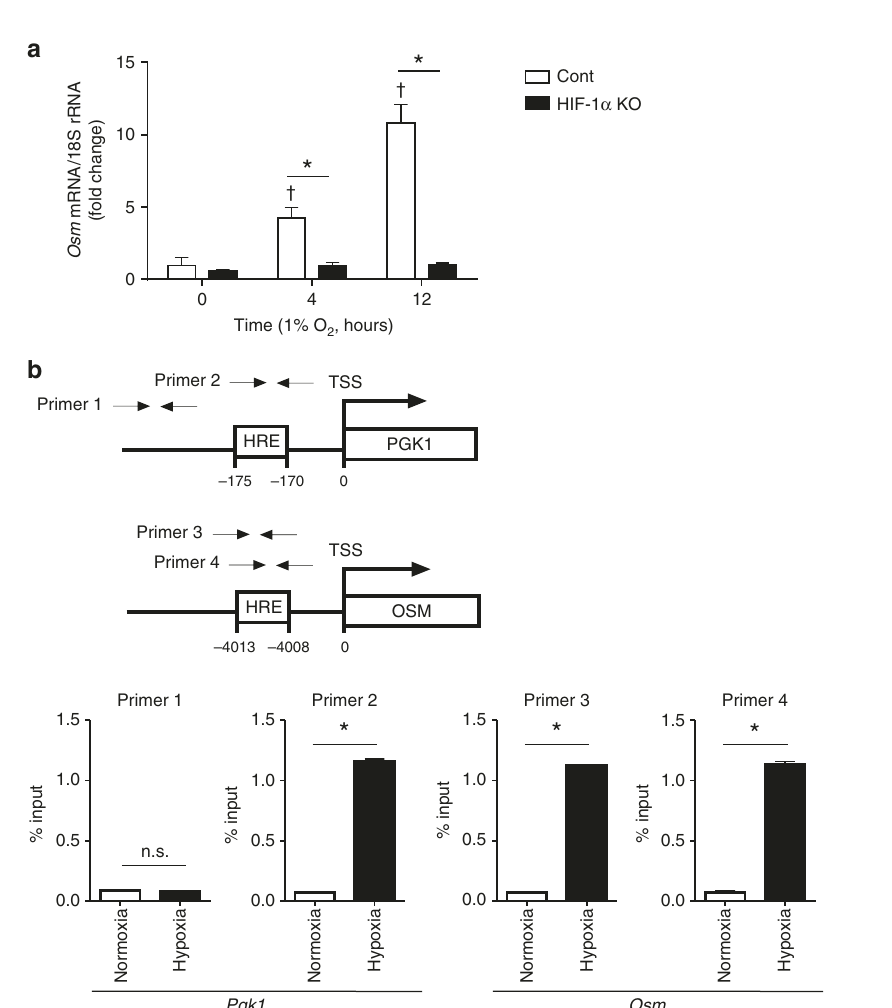
Fig. 3 Oncostatin M from hypoxic M Φ inhibits fi broblast activation. a Supernatants were collected from thioglycollate-elicited peritoneal macrophages (TEPMs) under normoxic or hypoxic condition. After pretreatment with the supernatants, C3H/10T1/2 cells were stimulated with TGF- β 1 (2.5 ng per ml, 12 h) and the relative expression of α SMA mRNA was calculated (right). The one-way ANOVA and Dunnett ’ s multiple comparisons test were used for the statistical analysis (F (2, 6) = 6.019). b We performed transcriptome analysis in isolated primary TEPMs from hematopoietic/endothelial-speci fi c HIF-1 α conditional knockout mice ( HIF-1 α fl ox/ fl ox ; Tie2-cre + / − mice; HIF-1 α KO) or cre negative littermate control. Flow chart shows the strategy to identify hypoxia-inducible secretory factors (left). Table illustrates the identi fi ed 11 hypoxia-inducible secretory factors (right). c The effect of each hypoxic inducible secretory factor in fi broblasts activation was examined (20 ng per ml for CTGF, CXCL2, CXCL3, LIF and 10 ng per ml for OSM). Thirty minutes after pretreatment with hypoxia-inducible secretory factors, C3H/10T1/2 cells were stimulated with TGF- β 1 (2.5 ng per ml, 12 h) and the relative expression of α SMA mRNA was calculated. The one-way ANOVA and Dunnett ’ s multiple comparisons test were used for the statistical analysis (F (5, 12) = 68.07). d The effect of oncostatin M (OSM) (10 ng per ml) in primary cardiac fi broblasts activation was examined. Thirty minutes after pretreatment with OSM (10 ng per ml, 12 h), C3H/10T1/2 cells were stimulated with TGF- β 1 (2.5 ng per ml, 12 h) and the relative expression of α SMA mRNA was calculated. Two-tailed t -test with Welch ’ s correction was used for the statistical analysis (t = 10.89, df = 2.208). Data show the mean and the standard deviation (error bar) of technical triplicates from a representative experiment. e Immunohistological staining were performed using cardiac tissues from TAC operated mice (day 3). OSM (left), CD11b (right). Scale bar = 50 μ m. * p < 0.05